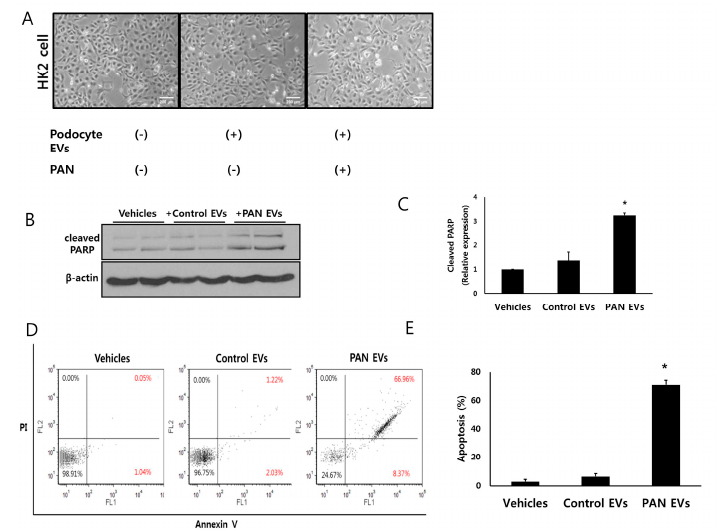
Figure 3. EVs from injured podocytes led to HK2 cell apoptosis ( A ) EVs from PAN-treated podocytes decreased the number of HK2 cells. ( B , C ) PAN-treated podocytes released EVs increased cleaved poly (ADP-ribose) polymerase (PARP) expression of HK2 cells (D,E) PAN-treated podocytes released EVs induced apoptosis of HK2 cells after co-incubation. PAN; puromycin nucleoside, PI; propidium iodide. * p < 0.05 vs. vehicles.